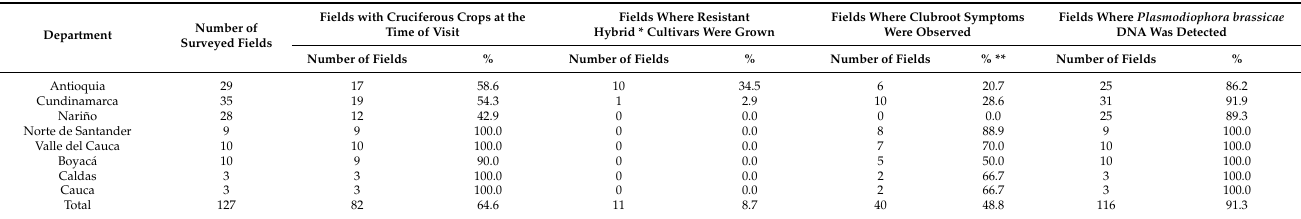
Table 2. Number of surveyed fields for clubroot presence in Colombia by department.